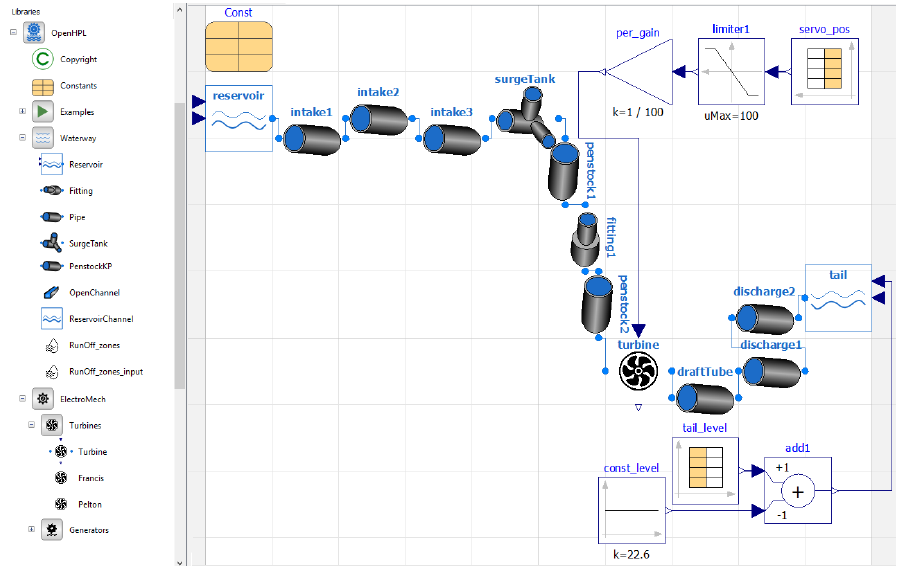
Figure 3. Flow sheet of the model of the hydropower system in OpenModelica. Modelled using OpenHPL